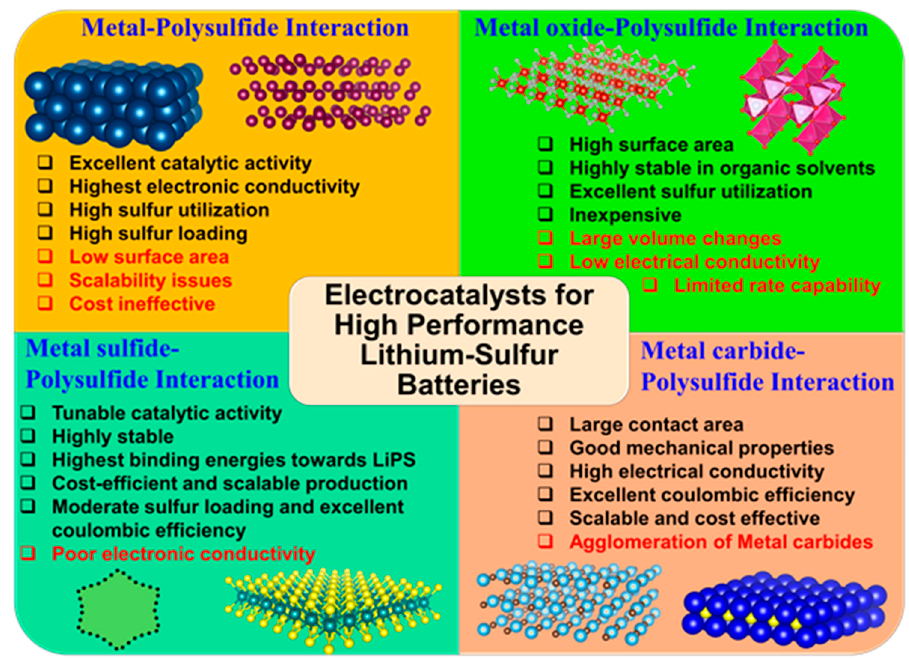
Figure 1. Schematic illustration representing the functions of an electrocatalytic sulfur host in a Li-S battery. The schematic was made using Materials Project Online software (database version 2019.05. Powered by Pymatgen version 2019.10.16) [63,64] and VESTA software [65] .